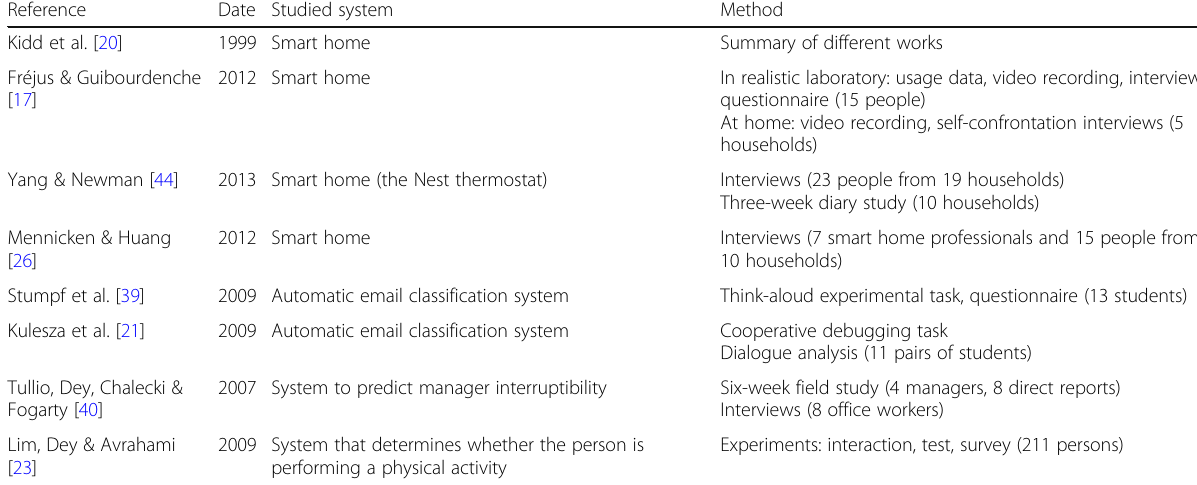
Table 2 Summary of the considered research papers about smart systems (in the text below by order of appearance)